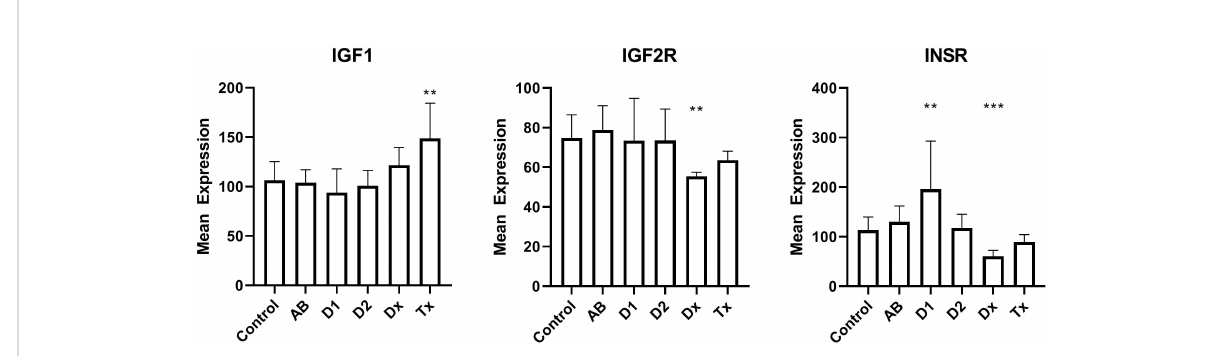
FIGURE 4 Islet mRNA expression of genes related to insulin action. Patient groups are identi fi ed in Figure 1, which also describes the statistical testing. *p<0.05, **p<0.01,